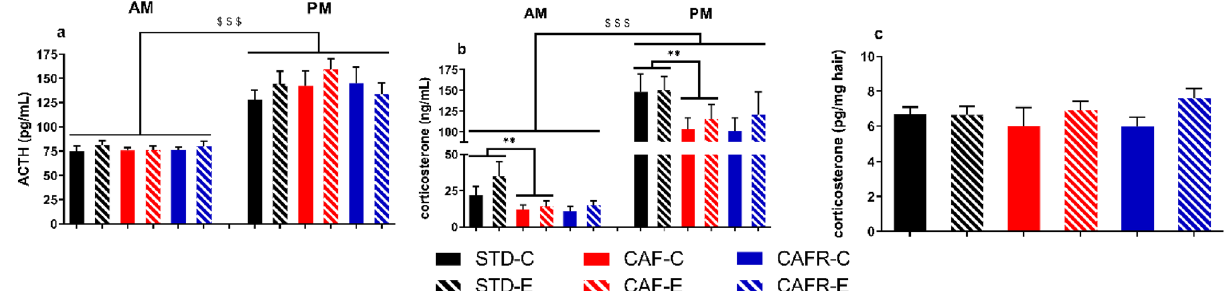
Figure 4. Effects of dietary interventions and exercise on circadian baseline levels of plasmatic corticosterone and ACTH, and hair corticosterone levels. ( a ) ACTH (pg/mL). ( b ) Corticosterone (ng/mL). ( c ) Hair corticosterone (pg/mg hair). Values are mean ± SEM. $$$ p < 0.001 versus AM levels; ** p < 0.01 versus